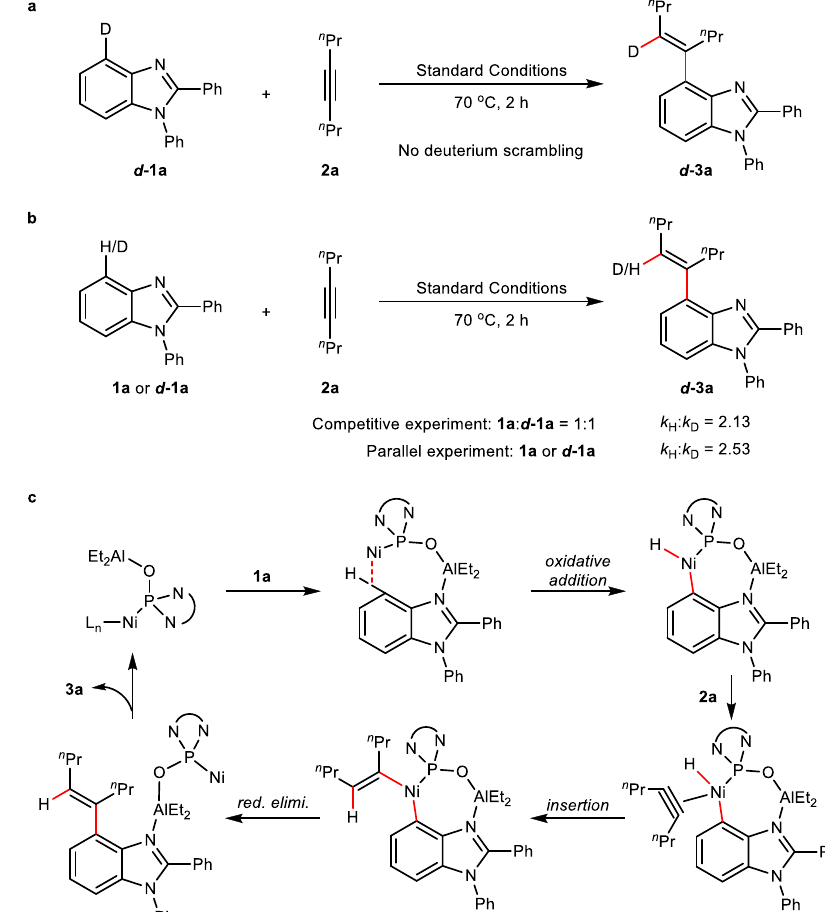
Fig. 6 Mechanistic experiments. a Deuterium-labeling experiment, showing that C4 − D was completely transferred to the alkene of the product. b Kinetic isotopic effect determination: a signi fi cant KIE for C4 − H bond suggests that the activation of C4 − H bond could be a rate-determining step. c Proposed